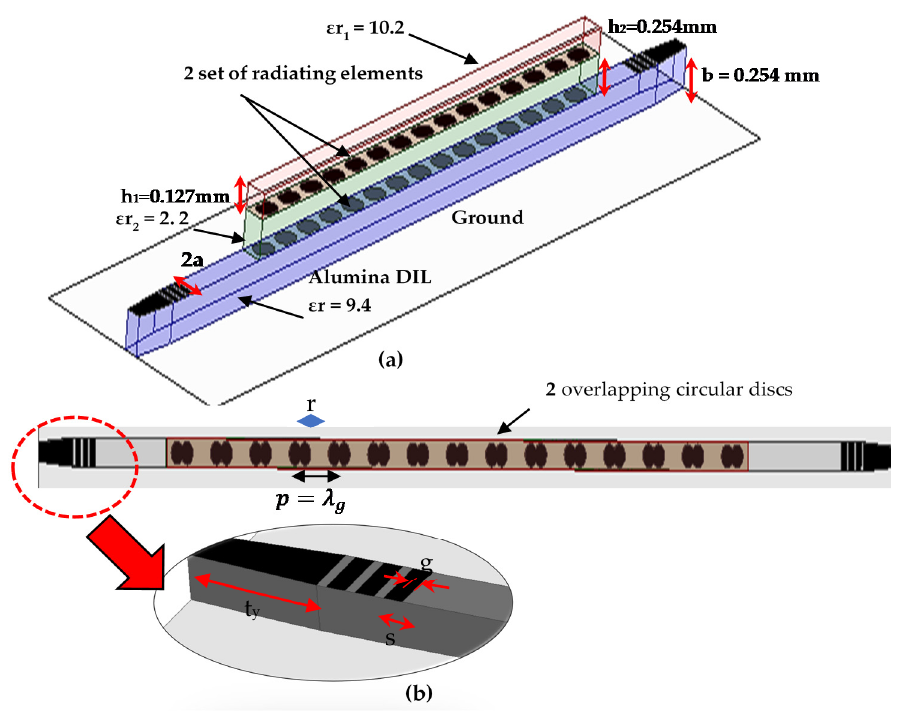
Figure 1. Layout of the proposed LWA. ( a ) Cross-sectional view of the array and ( b ) a top view of the structure along with the feeding network; 2a = 0.3, p = 0.8, t y = 0.7, S = 0.12, g = 0.1, r = 0.1mm, b = 0.254, h 2 = 0.254, h 1 = 0.127, (Unit: mm).